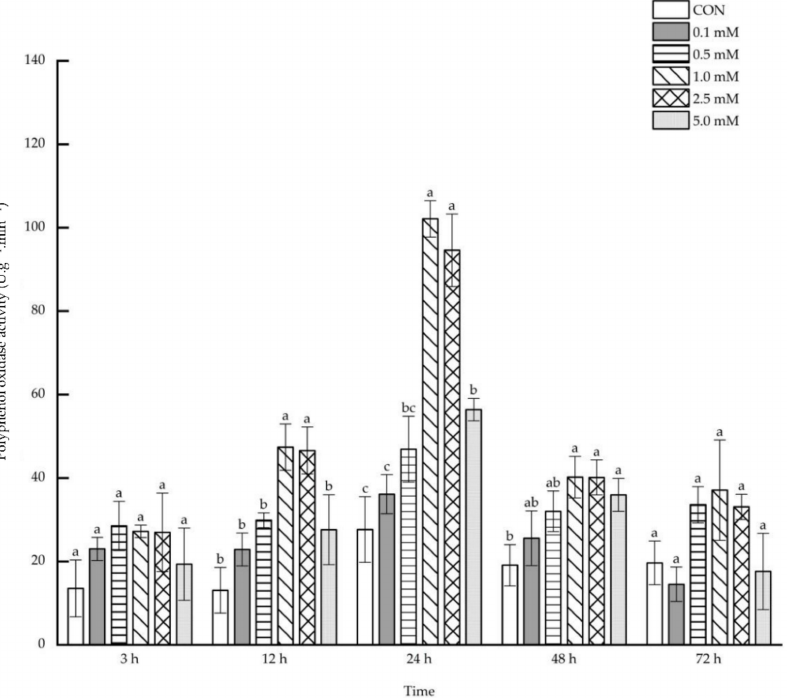
Figure 9. The systemic effect of the SA concentration and post-treatment time on the polyphenol oxidase activity in roots following exogenous foliar application. The data are presented as mean ± standard errors. The significance of data was determined by the Duncan method. The difference between different letters at the same time reached significant levels of